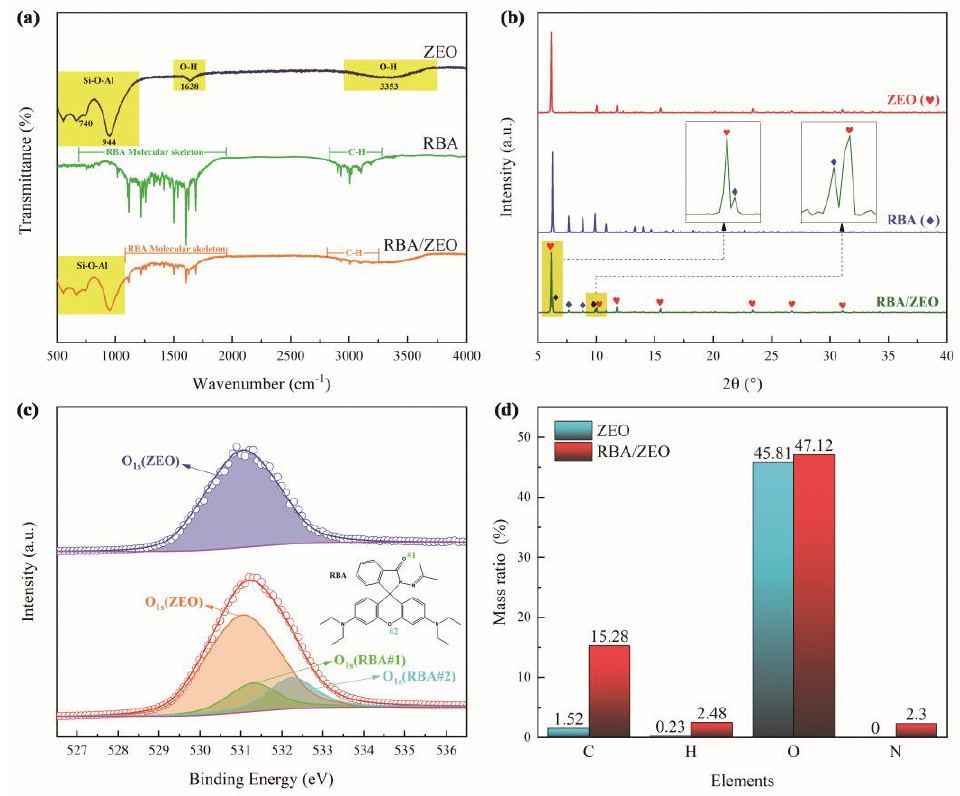
Figure 3. Structure and composition characterization of ZEO and RBA/ZEO, ( a ) infrared spectrum, ( b ) XRD, ( c ) XPS of O element and ( d ) element analysis.